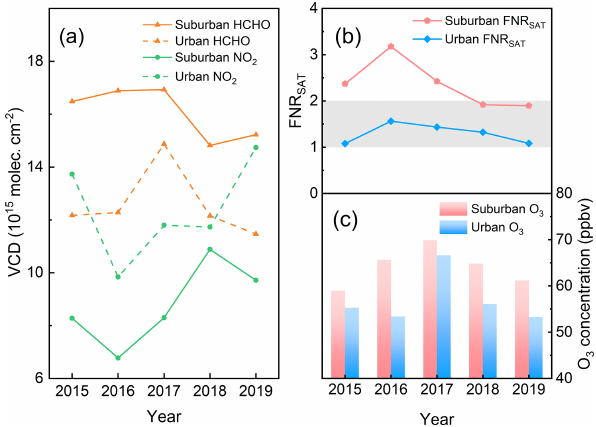
Figure 7. Differences of (a) satellite observation of HCHO and NO 2 VCDs, (b) FNR SAT , and (c) surface O 3 concentration in urban and suburban areas of Shanghai from 2015 to